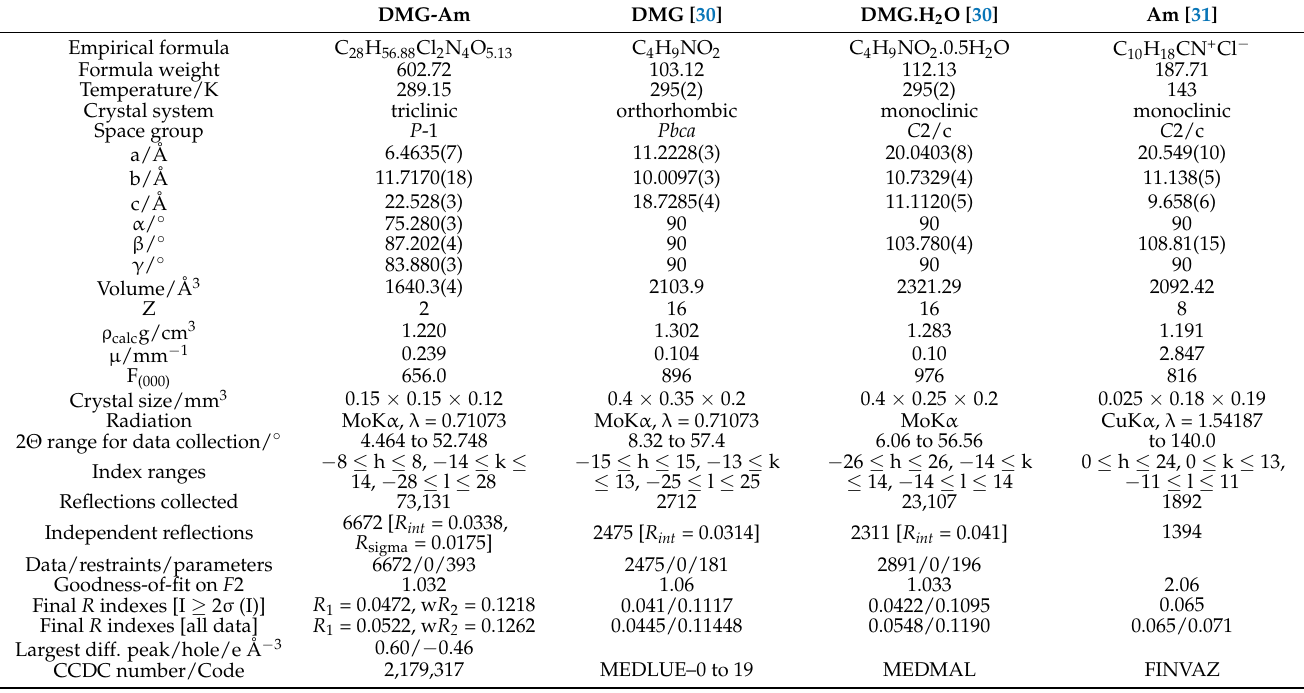
Table 1. Most important data collection and crystallographic refinement parameters for DMG-Am, DMG, and DMG.hemihydrate and amantadine